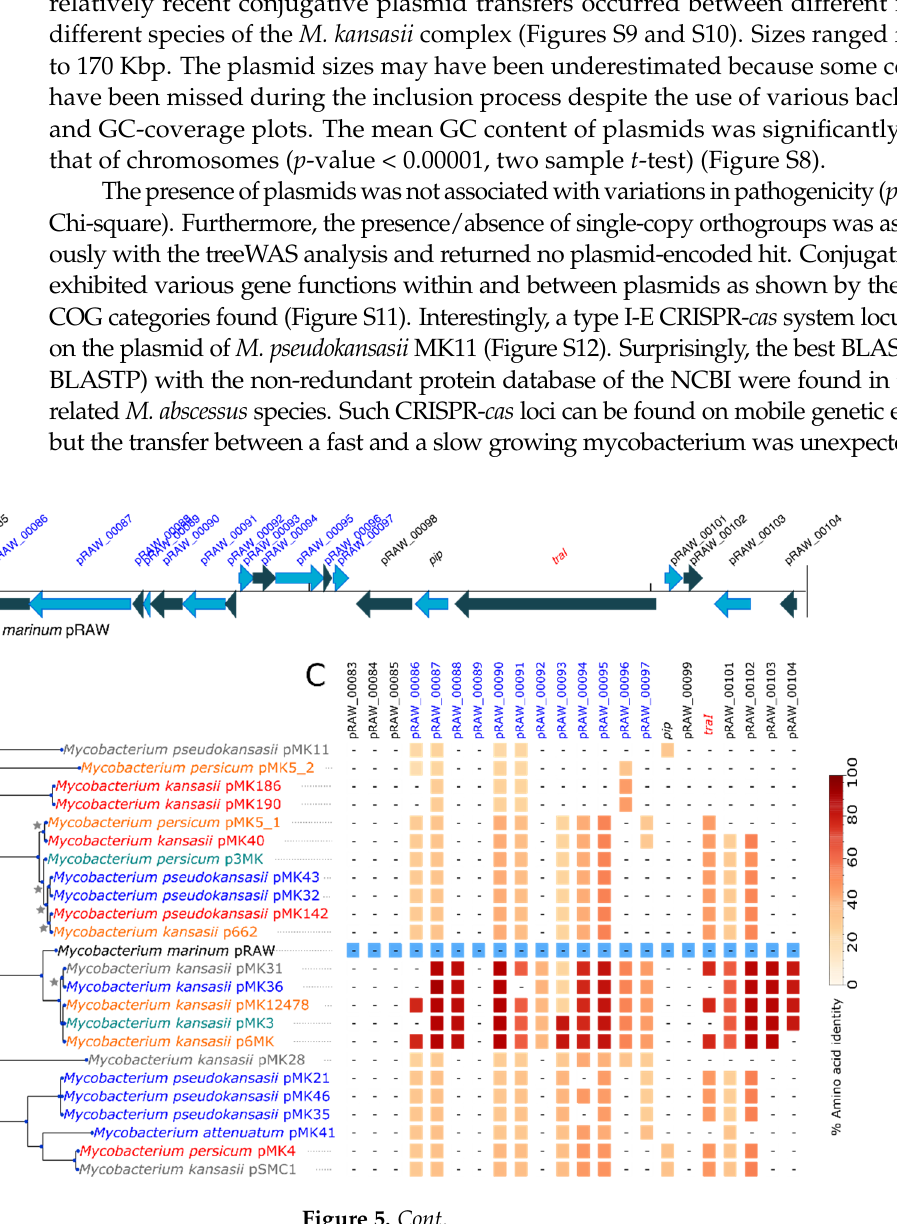
Figure 5. Distribution of the conjugative plasmids detected in the M. kansasii complex. ( A ) The type-IV secretion system locus (in blue), as well as the relaxase ( traI ) of the reference conjugative plasmid of M. marinum pRAW (as described in Ummels et al. [31]), is conserved ( C ) in some mem- bers of the M. kansasii complex. For multiple-copy orthologous groups, the amino acid identity of the best hit is shown. The reference sequences used to build this plot are indicated in blue. ( D ) Schematic representation of the plasmid-encoded Type-VII secretion system of strain ATCC 12478 and its gene conservation ( F ) in members of the M. kansasii complex. ( B , E ) Maximum-likelihood phylogeny based on the concatenated alignment of six single-copy orthologous genes (2766 amino acids) of the plasmid dataset. Bootstrap values below 0.9 are indicated with grey stars. The colors of the labels indicate pathogenicity, as reported in Table 1. Red = 1 = pathogenic, Orange = 2 = probably pathogenic, Grey = 3 = unknown, Green = 4 = probably non-pathogenic, Blue = 5 = non-